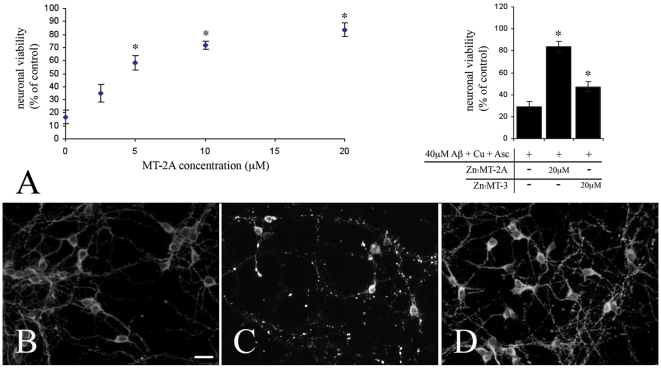
Treatment of 3DIV rat cortical neuron cultures with 40µM Aβ1–40 (in the presence of 40µM CuCl2 and 300µM ascorbate) resulted in approximately 80% reduction in neuronal viability 24 hours after treatment (A).20µM of Zn7MT-2A was far more effective in protecting against Aβ1–40 neurotoxicity than 20µM Zn7MT-3 (A). Immunolabelling for tau demonstrated smooth cytoskeletal labelling in control (B) neurons, which became punctate and disassociated following Cu(II)Aβ1–40 treatment (C). Treatment with 20µM Zn7MT-2A prevented Aβ-induced structural changes in the neuronal cytoskeleton (D). Scale bar = 25mm.